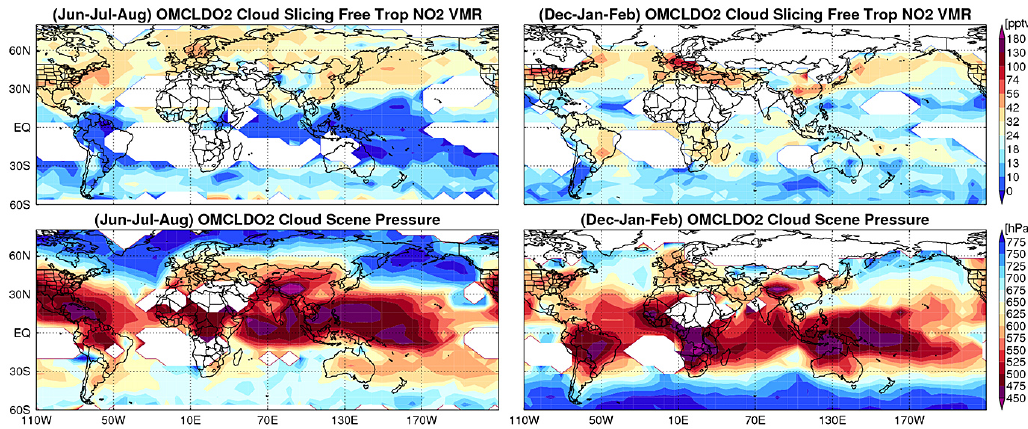
Figure D4. For June–August (left) and December–February (right) averaged over 2005–2007, top: global maps of NO 2 VMR calculated using geometric AMFs and OMCLDO2 cloud parameters; bottom: mean cloud scene pressures from